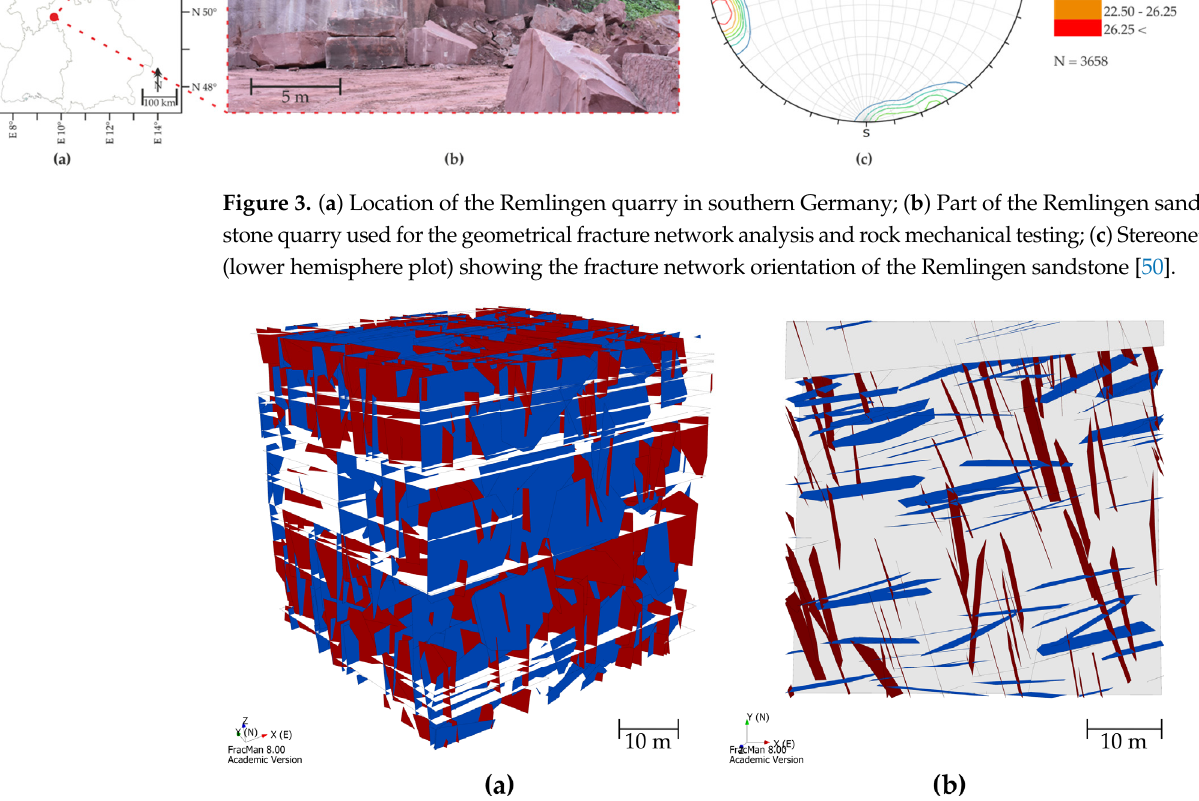
Figure 4. ( a ) Stochastic DFN model of Remlingen, including two horizontal discontinuity sets and one vertical discontinuity set; ( b ) Top view of the DFN model. The edge length of the DFN cube is 50 m, similar to the dimensions of the project domain.